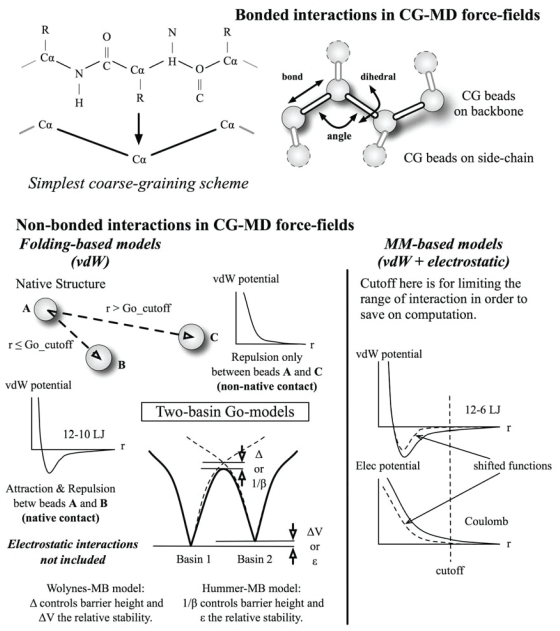
Interactions between CG-beads can be broadly divided into ‘bonded’ (bond, angle, dihedral) and non-bonded. For MM-based models, non-bonded interactions include vdW and electrostatics which are commonly represented by 12-6 LJ and Coulomb potentials, respectively. For Folding-based models, pairs of beads in native contact (separation within a cutoff of about 8 Å) in the reference structure are under vdW interactions (commonly represented by 12-10 LJ) while those not in native contact repel from each other. The folding (free) energy surface for each protein structure can be described by a smooth funnel-shaped basin with the native conformation having the minimum energy at the bottom of the basin. These basins can be connected with adjustable relative stability and barrier height to study conformational transitions.